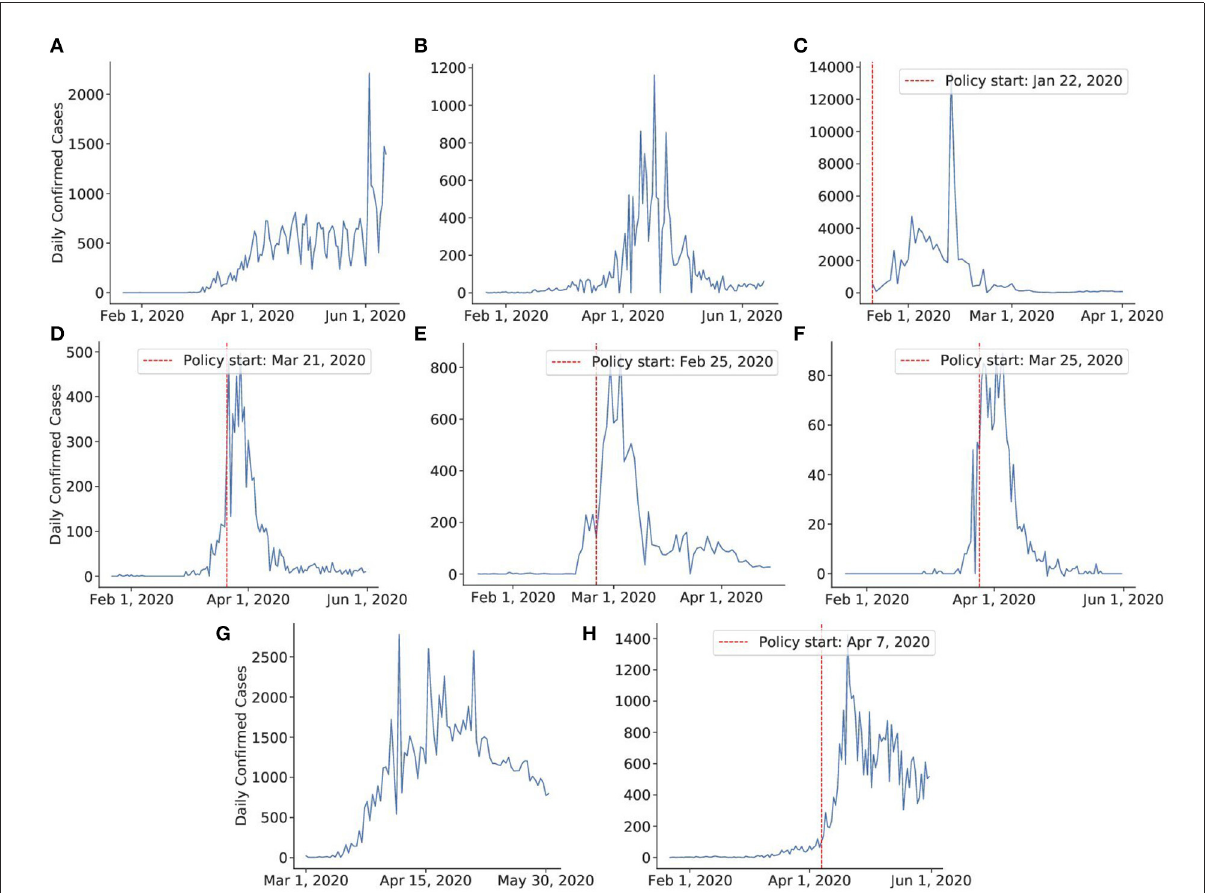
FIGURE2 Daily number of confirmed cases of eight countries. Vertical red lines indicate the date when a certain policy was established. In the case of Sweden and Japan, we consider the time period before the policy establishment. For Canada, the policy was established gradually. Thus, the exact dates of policy start for this country are not determined. (A) Sweden, (B) Japan, (C) China, (D) Australia, (E) Korea, (F) New Zealand, (G) Canada, (H)